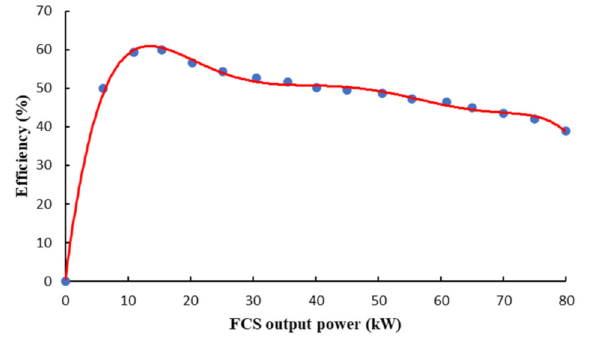
Figure 5. Fuel cell system